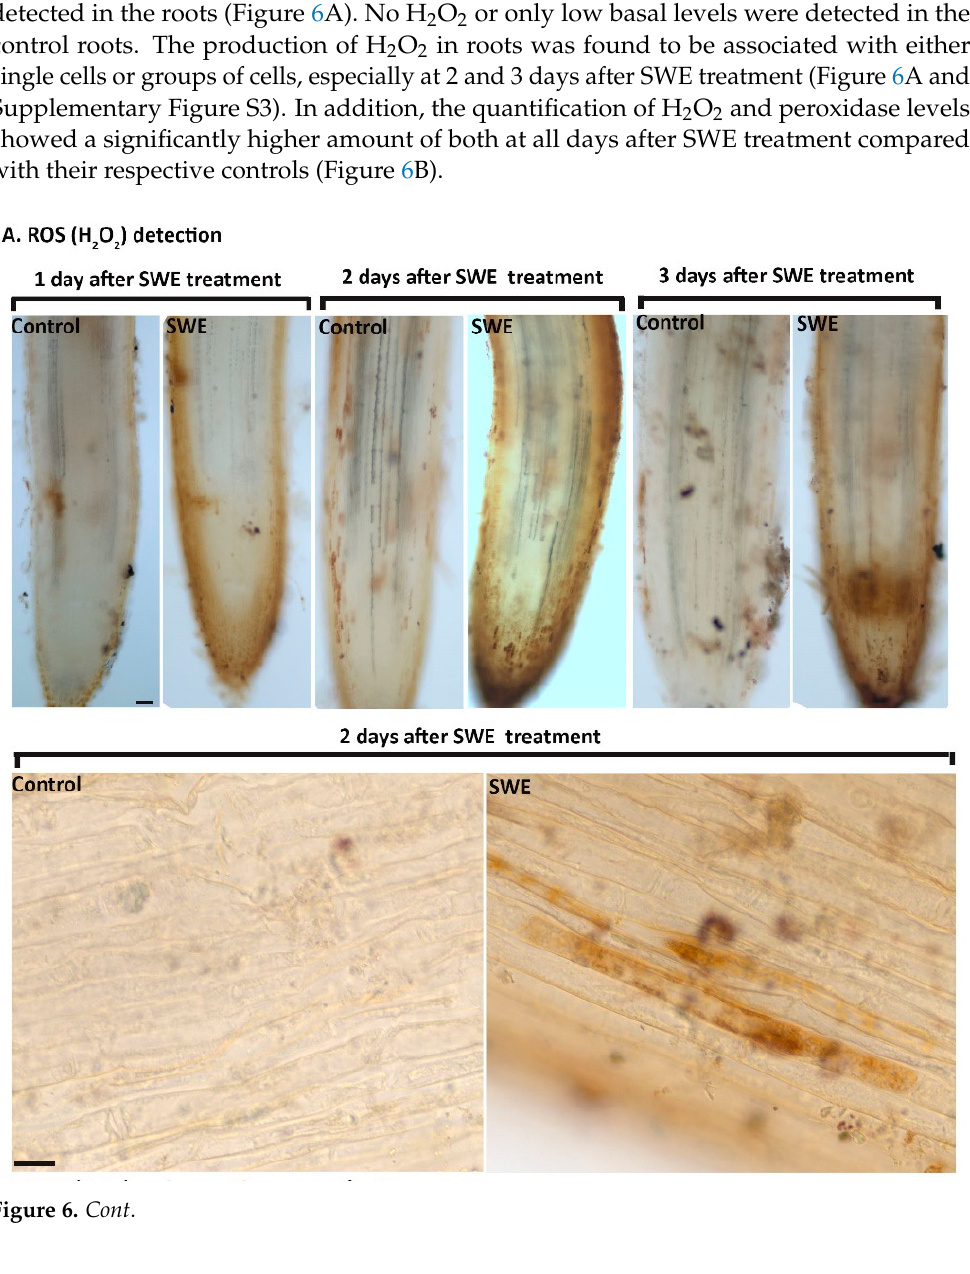
Figure 6. Detection and quantitation of hydrogen peroxide and peroxidase in S. lycopersicum roots grown in the sand culture system and treated with a single application of SWE or water as the con- trol. ( A ). The SWE-treated roots harvested at 1, 2 and 3 days after the application showed higher production of H 2 O 2 compared to their respective control. Scale bar = 50 µm. Individual root cells 2 days after SWE application were DAB positive. Scale bar = 20 µm ( B ). H 2 O 2 and peroxidase quanti- fication from tomato roots grown with SWE or water as the control. Data shown are the mean of three independent biological replicates (each replicate consisted of 10 plants) and bars represent the